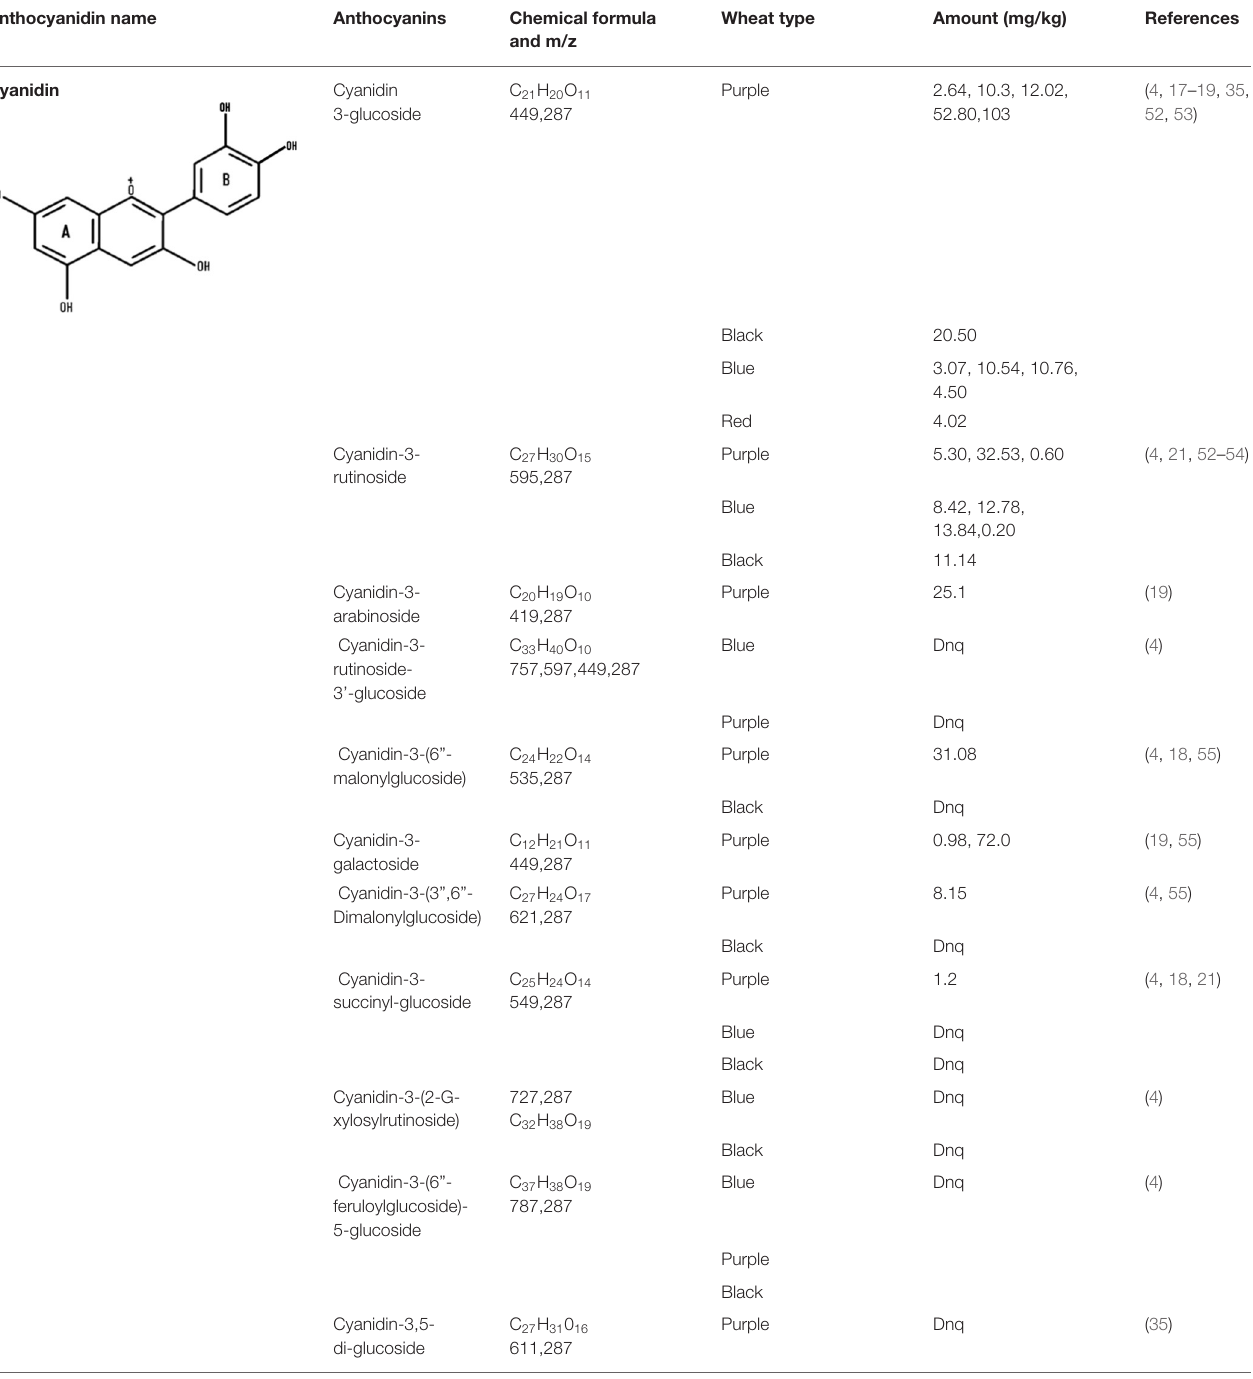
TABLE 1 | Anthocyanin composition in colored wheat grains. Anthocyanidin name